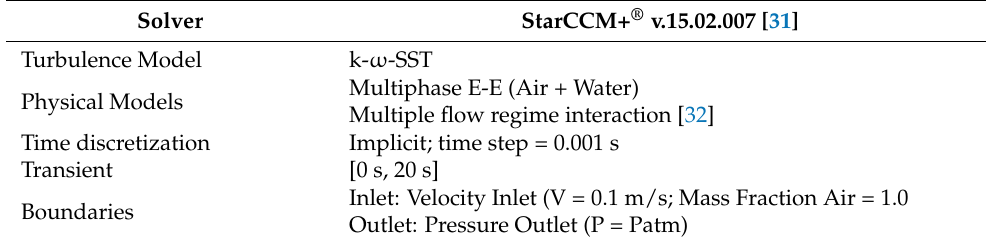
Table 1. Main CFD model parameters.